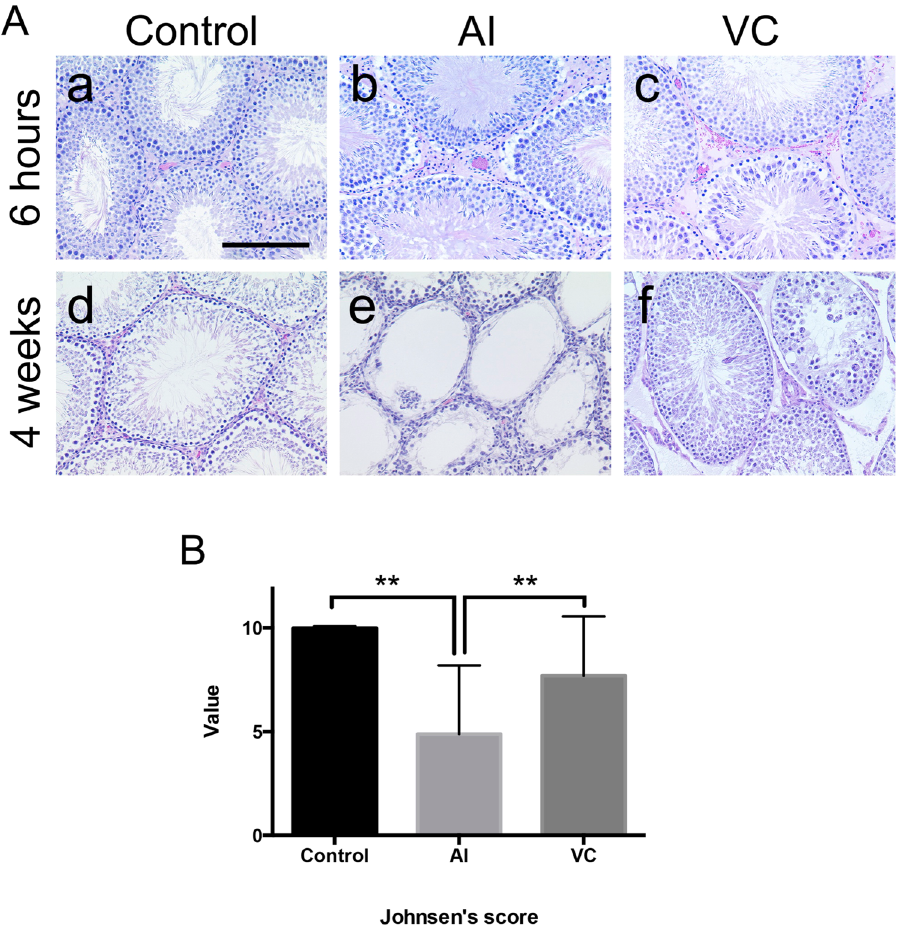
Figure 2. Histopathological changes in rat testes with arterial ischaemia (AI) and venous congestion (VC) and after their reperfusion. A: ( a ) Control. ( b ) 6 h after AI. ( c ) 6 h after VC. ( d ) control after 4 weeks. ( e ) 4 weeks after reperfusion of AI. ( f ) 4 weeks after reperfusion of VC. Interstitium area in ( c) showing the haemorrhage. Bar = 50 μ m. B: Degrees of spermatogenesis at 4 weeks after reperfusion of AI or VC. Data are expressed as means ± standard deviation, and the two-way analyses of variance and Tukey–Kramer tests were used for statistical analyses. P > 0.05 was considered as indicating nonsignificant differences. ** P <